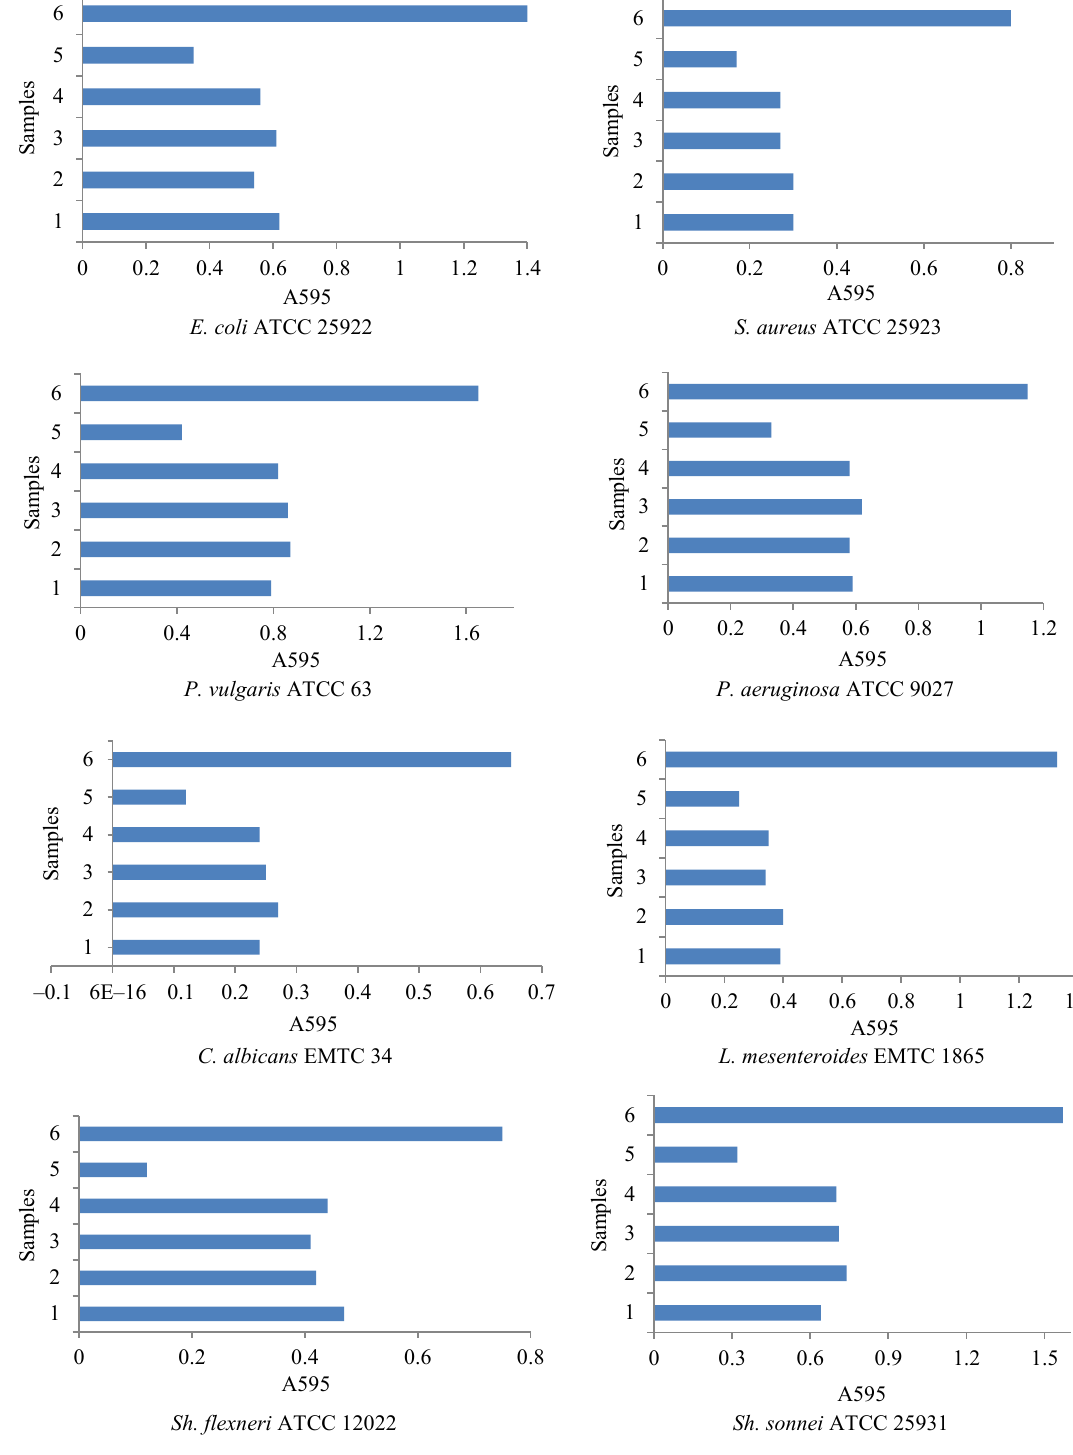
Figure 3 Antimicrobial activity of suspension extracts (optical density method): 1 – Eleutherococcus senticosus ; 2 – Codonopsis pilosula ; 3 – Platanthera bifolia ; 4 – Saposhnikovia divaricata ; 5 – ciprofloxacin; 6 –